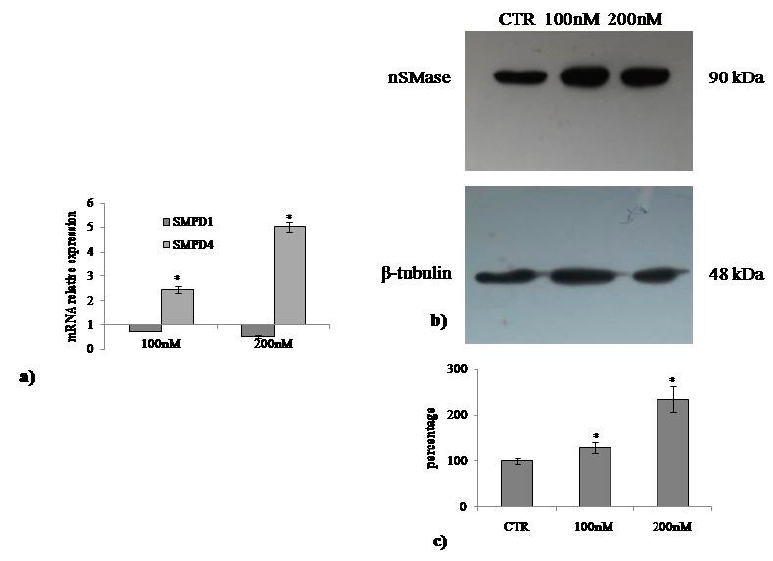
Figure 5. E ff ect of VD3 on nSMase. ( a ) Gene expression evaluated by RT-PCR; ( b ) immunoblotting, with the position of the 90 kDa protein for nSMase and 48 kDa for β -tubulin indicated in relation to the position of molecular size standards; ( c ) area density evaluated by densitometry scanning and analyzed with ImageJ program. Values of nSMase, normalized with β -tubulin, are expressed as fold changes with respect to the control sample, which is considered equal to 1. Significance, * p < 0.001 versus control sample.